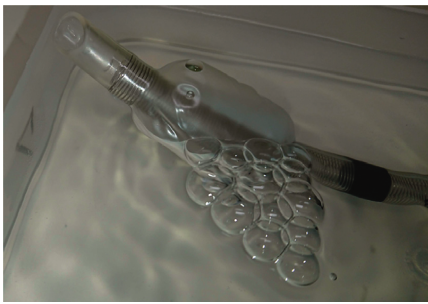
Figure 1: Ruptured cuff of the used ETT. When the air was inflated, air bubbles were leaking from the single, ruptured pinhole of the